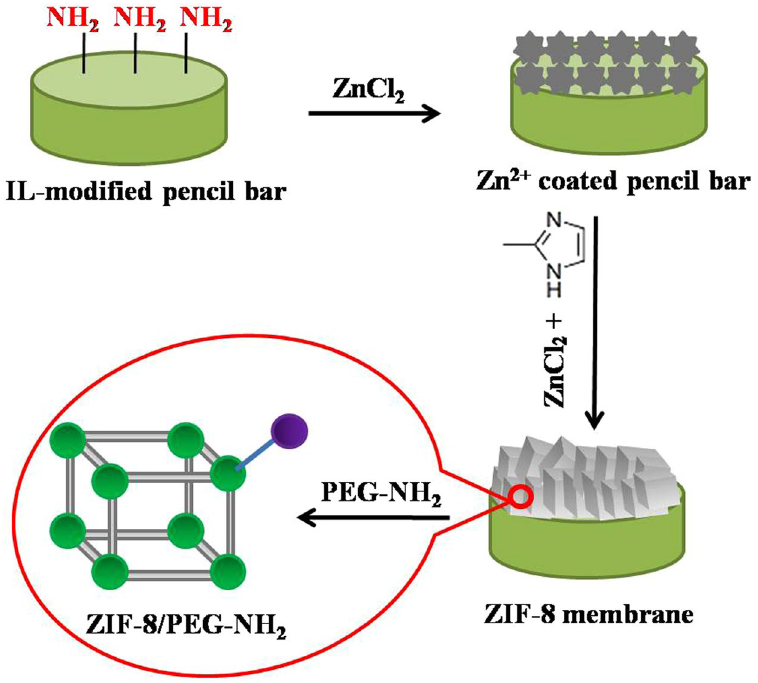
Figure 1. Schematic diagram of the preparation of PEG-NH 2 -functionalized ZIF-8